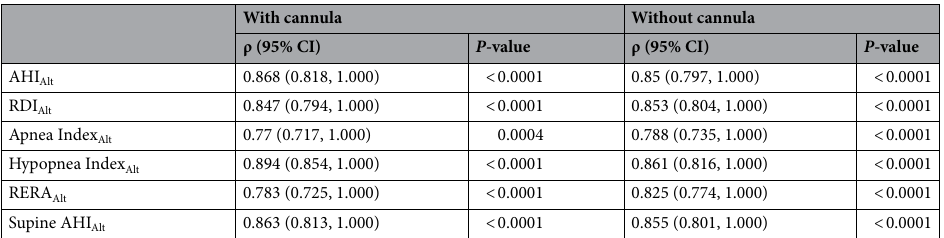
Table 2. Interclass correlation between respiratory events scored from infrared optical gas images with standard sensor (Alt data) and from PSG. AHI apnea–hypopnea index, Alt infrared with standard sensor, CI confidence interval, PSG polysomnography, RDI respiratory disturbance index, RERA respiratory effort-related